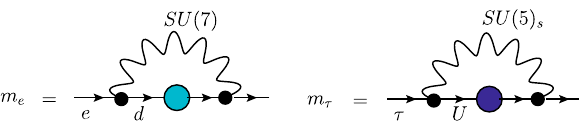
Fig. 5 Leptonic masses in the TC coupled scenario generated in mod- els of the type of Eq.